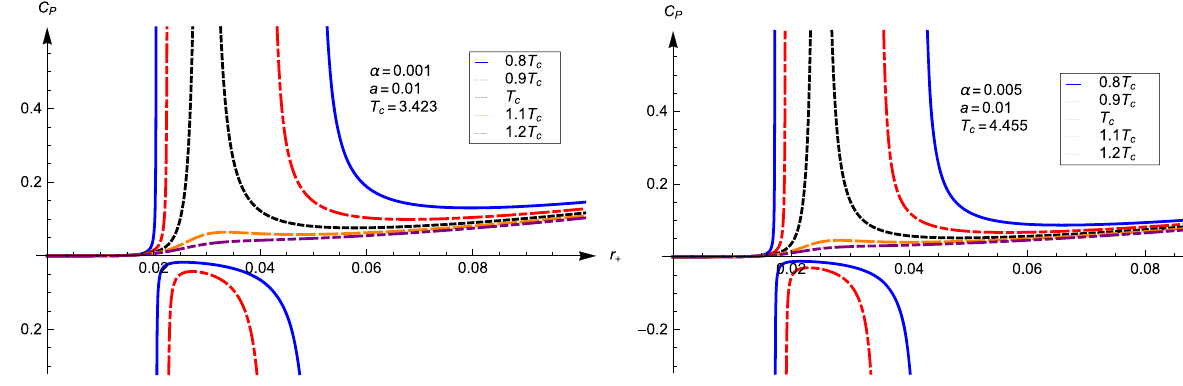
Fig. 3 Heat capacity versus r + for a = 0 . 01 and α = 0 . 001 (left panel), and α = 0 . 005 (right panel)